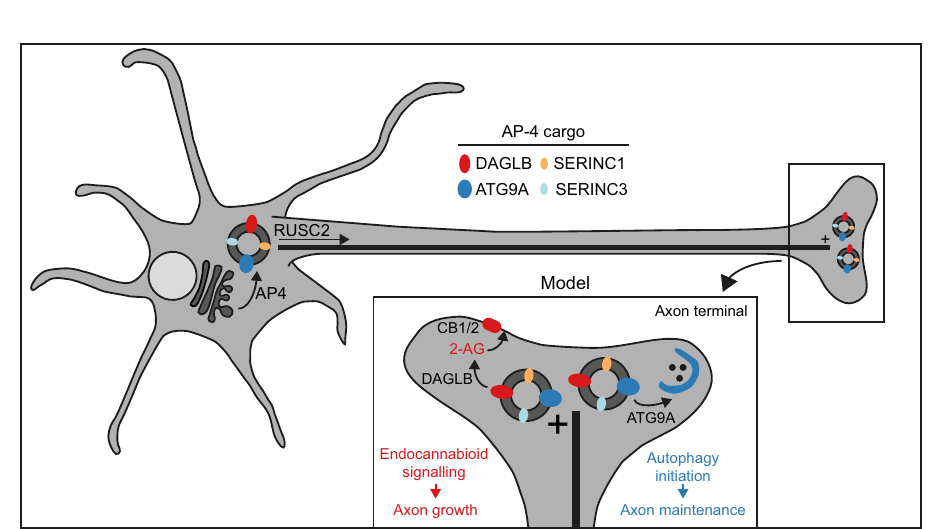
Fig. 7 2-AG and AA are reduced in AP-4 knockout brains and MGLL inhibition rescues impaired neurite outgrowth in AP-4-de fi cient neurons. a Diagram of the 2-AG biosynthesis pathway. Hydrolysis of diacylglycerol (DAG; blue) by DAG lipase (DAGL; blue) generates 2-arachidonoylglycerol (2-AG; green), which is hydrolysed by monoacylglycerol lipase (MGLL; green) to generate arachidonic acid (AA; purple). MGLL inhibition by the speci fi c inhibitor ABX-1431 (red) blocks 2-AG hydrolysis and thereby increases the level of 2-AG 33 . b – d Mass spectrometry-based quanti fi cation of ( b ) 2-AG, ( c ) AA and ( d ) 1-stearoyl-2-arachidonoyl-sn-glycerol (SAG), from wild-type (WT) and Ap4e1 knockout (KO) mouse brains ( n = 5 animals per group; horizontal bar indicates median; mice were aged 6 months). Data were subjected to a two-tailed Mann – Whitney U -test. e Neurite outgrowth was assayed in iPSC-derived cortical neurons from a patient with AP4B1 -associated AP-4 de fi ciency syndrome (SPG47; patient 1) and their unaffected same sex heterozygous parent (control), using automated live cell imaging. Neurons were cultured in the presence of DMSO (vehicle control) or the MGLL inhibitor ABX-1431 at 10, 50, 100 or 500 nM (the highest two doses were administered only to the patient neurons). Neurons were monitored from 4 h post-plating, with images captured every 3 h until 25 h post-plating. Representative images are shown at 4 h (t0) and 25 h post-plating, with cell bodies outlined in green and neurites traced in red. Scale bar: 100 μ m. f – h Automated image analysis from neurite outgrowth assay of two separate neuronal differentiations per cell line shown in ( e ). Graphs show neurite length per image over time, normalised to cell body cluster area. Data are shown relative to normalised neurite length at t0. The same data are shown for the control plus DMSO condition in ( f – h ) and for the patient plus DMSO condition in ( f ) and ( g ). f Average neurite length of patient neurons was signi fi cantly reduced compared to control neurons at all time points. Per group, n = 108 images from two biological replicates were analysed. Data were subjected to a two-way repeated measures ANOVA with Š ídák ’ s multiple comparisons test for comparisons at each time point between control and patient: *** p ≤ 0.001. g Average neurite length of patient neurons was rescued by treatment with 10 nM ABX-1431. 50 and 100 nM ABX-1431 doses also increased neurite length, whereas neurite length was not improved by the highest dose (500 nM). Per treatment group, n = 18 images from two biological replicates were analysed. Data were subjected to a two-way repeated measures ANOVA with Dunnett ’ s multiple comparisons test for comparisons at each time point between each dose of ABX-1431 and the patient plus DMSO control: ** p ≤ 0.01; * p ≤ 0.05. The control plus DMSO condition is shown for reference, but was not included in the statistical analysis. h Average neurite length of control neurons was not affected by treatment with 10 or 50 nM ABX-1431. Per treatment group, n = 18 images from two biological replicates were analysed. Data were subjected to a two-way repeated measures ANOVA with Dunnett ’ s multiple comparisons test for comparisons at each time point between each dose of ABX-1431 and the DMSO control: * p ≤ 0.05. In ( f – h ) only signi fi cant changes are annotated; all other comparisons resulted in non-signi fi cant p values ( p > 0.05). Source data are provided